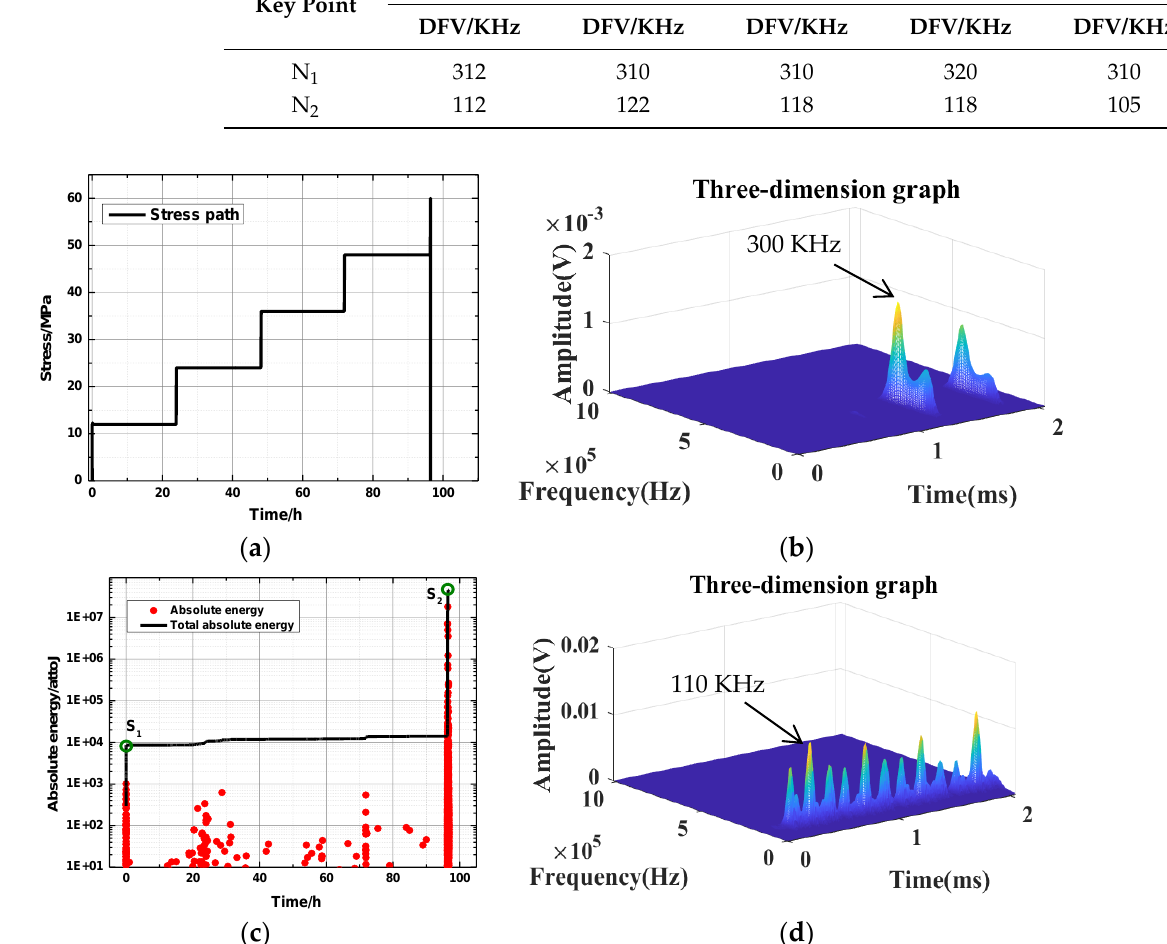
Figure 11. Stress with time for a 30-degree bedding angle under the saturated state: ( a ) the actual stress path; and ( c ) the corresponding acoustic emission energy curve. Images ( b , d ) are the waveform characteristics of key points. Table 5. AE energy level for different bedding angle under saturated state.